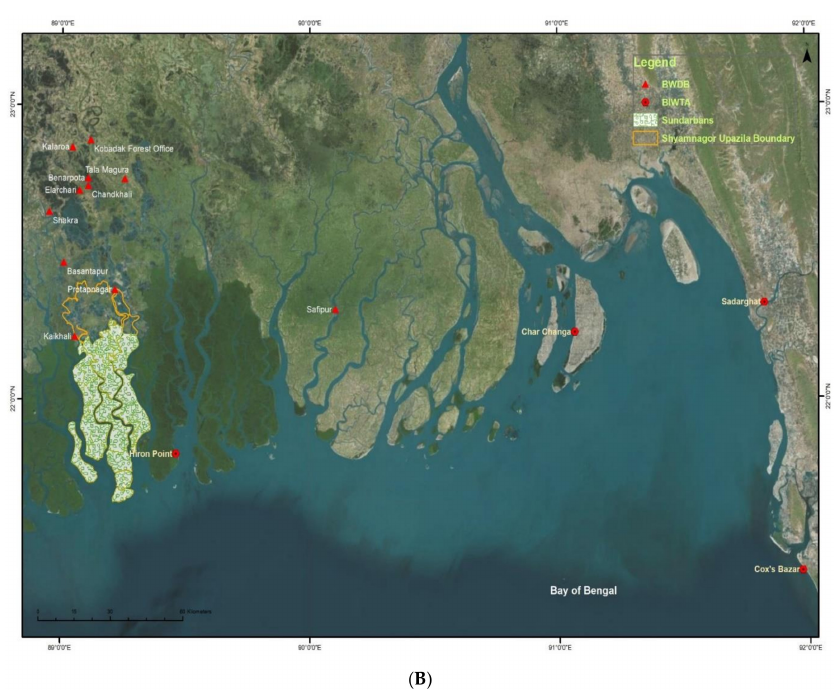
Figure 1. ( A ) The Ganges–Brahmaputra–Meghna (GBM) Delta with study area. ( B ) The study area with the three tide gauge stations of Hiron Point, Char Changa, and Cox’s Bazar, along with